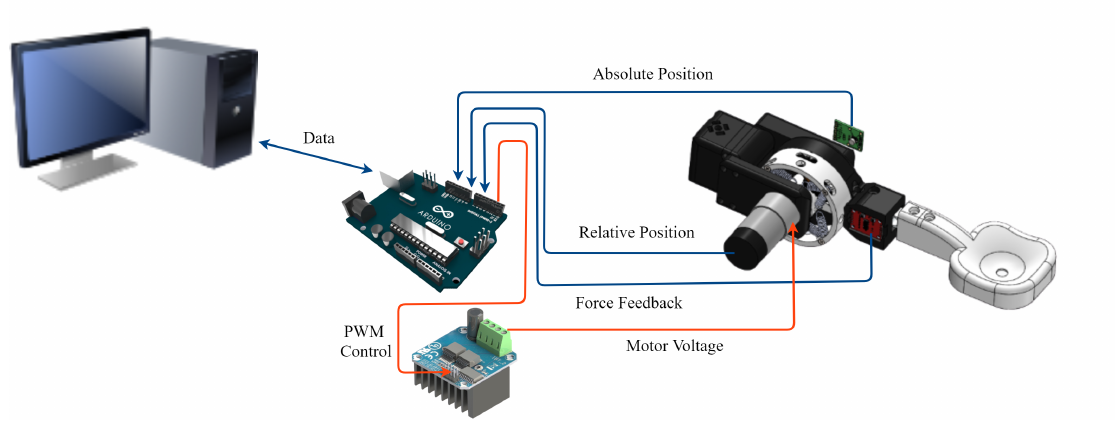
Figure 6. Data acquisition system—test